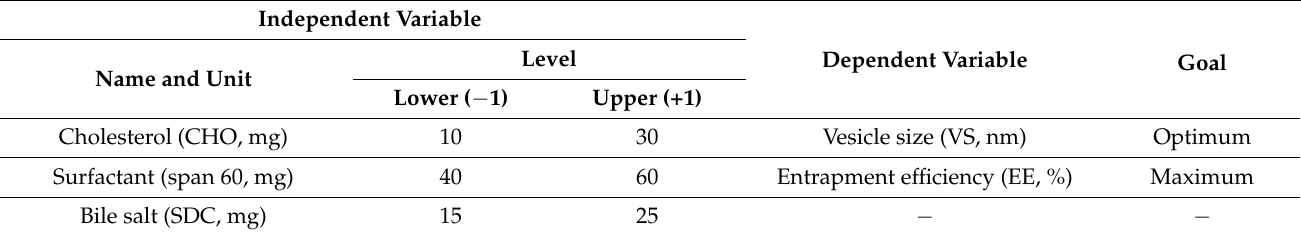
Table 4. Ingredient, levels, and constraints for optimization of formulation using